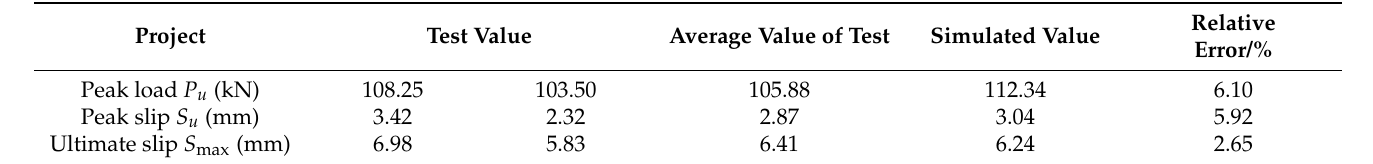
Figure 17. Static test failure mode of the push-out specimen: ( a ) stud; ( b ) welding ring; ( c ) concrete.